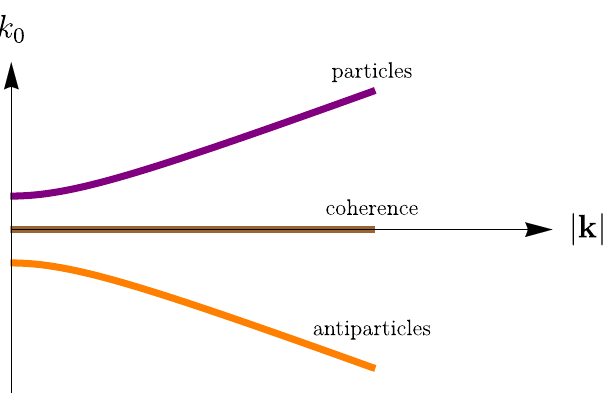
( k 0 ; t ), showing the particle shell k